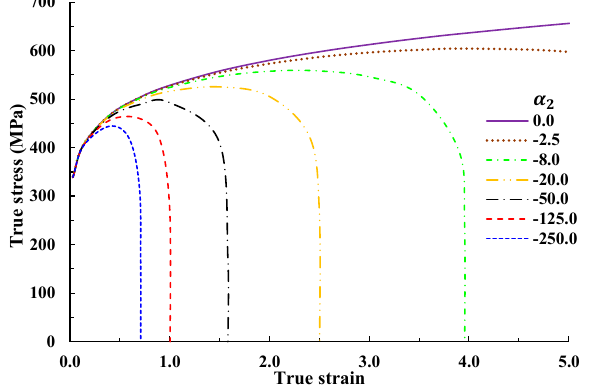
Figure 7. Flow curves derived using negative α (cid:2870) values.